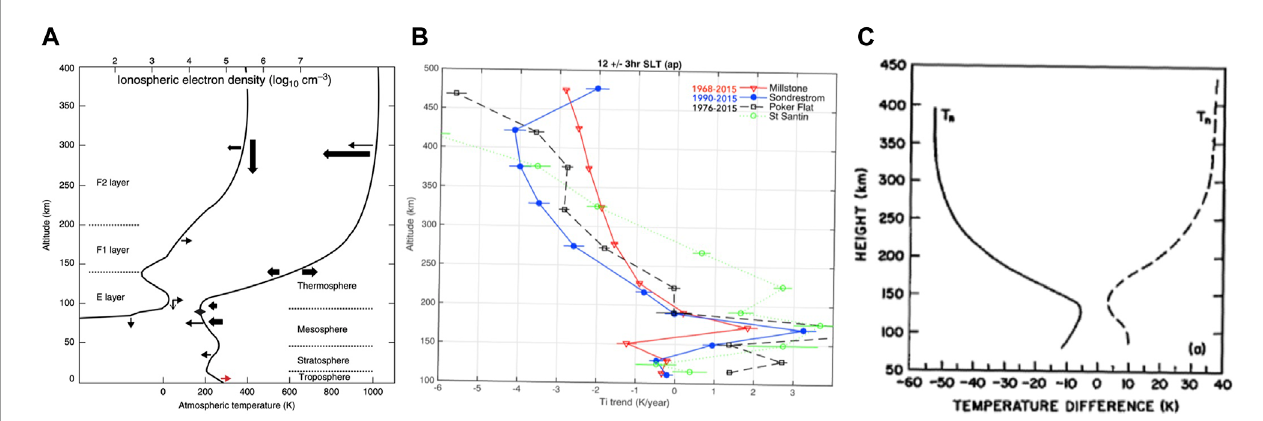
FIGURE 1 Ionospheric and thermospheric long-term trends: (A) observations in electron density (solid line on the left) and neutral temperature (solid on the right), after Laštovička et al. (2006); (B) incoherent scatter radar ion temperature observations at Millstone Hill (red), Sondrestrom (black), and Poker Flat (blue), after Zhang et al. (2016); (C) simulated thermospheric temperature changes due to doubling CO 2 mix ratio at ∼ 60 km altitudes (the left solid curve; the right dashed curve is for CO 2 halved), after Roble and Dickinson (1989).